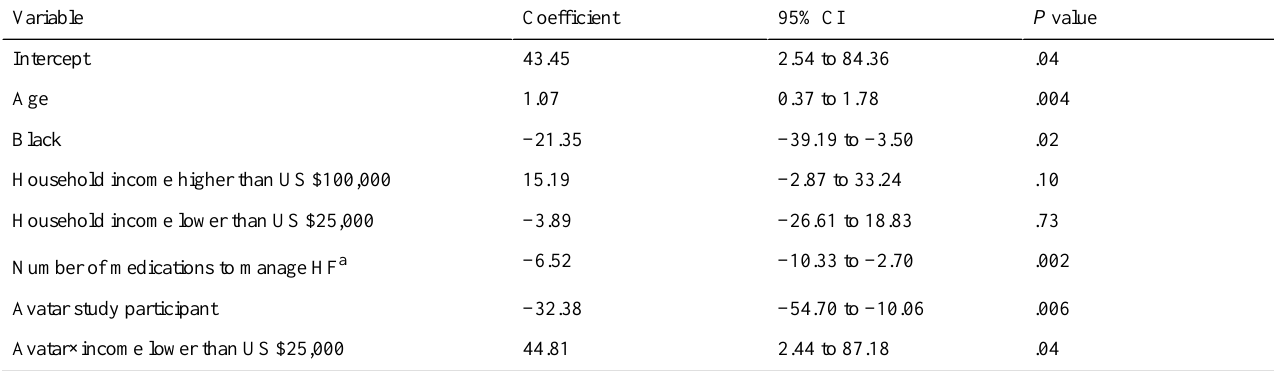
Table 3. Linear regression model for predicting the number of times that the patient used the voice interface technology, with an added interaction